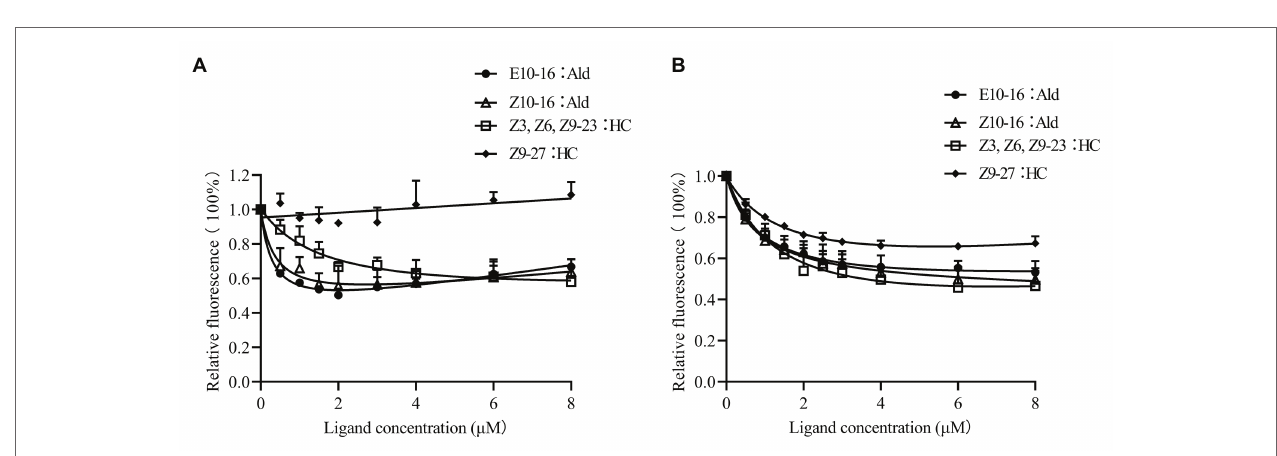
FIGURE 10 | Competitive binding curves of CpunPBP5 (A) and CpunOBP2 (B) to sex pheromones. Data are shown as mean ± SD, from three